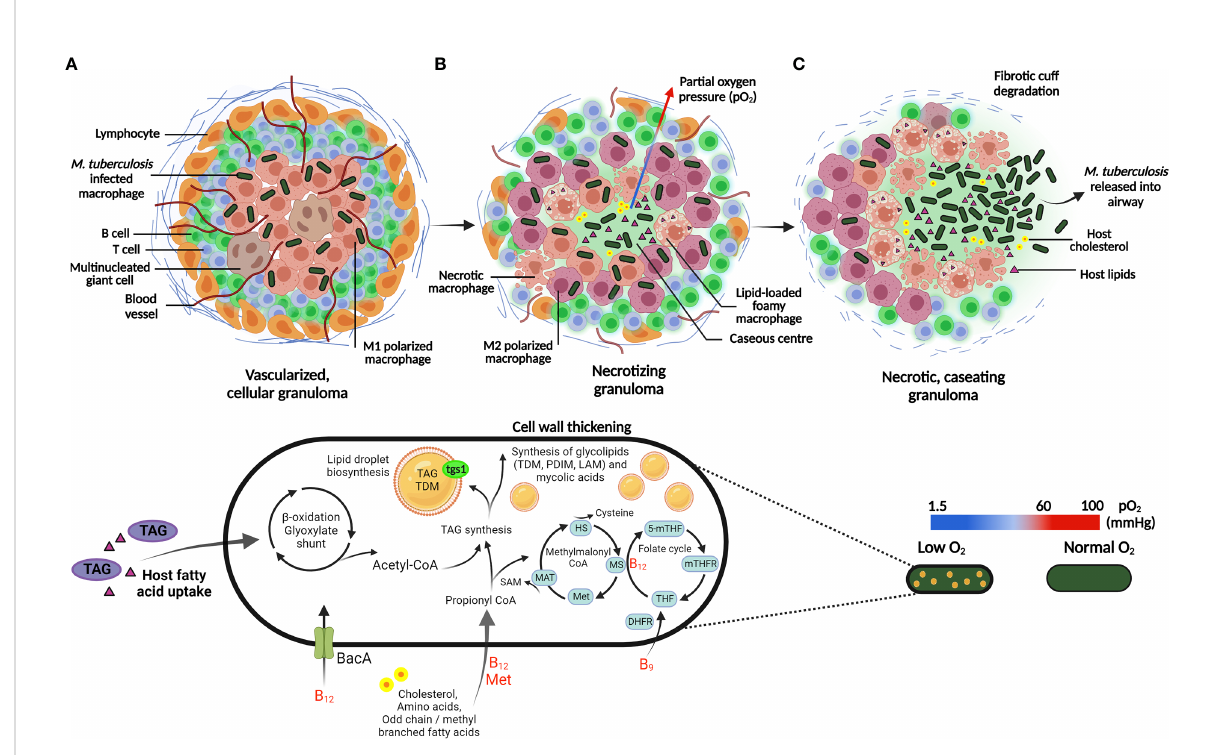
FIGURE 3 Adaptation of M. tuberculosis to the host granuloma environment and associated stressors. (A) M. tuberculosis is phagocytosed by alveolar macrophages and contained within the center of the granuloma, which is an organized aggregate of immune cells recruited to the site of in fl ammation. The pro-in fl ammatory cytokines, IFN-y and TNF- a activate macrophages (M1 polarized; pink macrophages), which is essential for the control of infection. Following host immune activation, recruitment of lymphocytes, largely comprising of T and B cells, surround the periphery of the granuloma. (B) Mature granulomas develop heterogeneous vasculature, displaying a gradient of pro-in fl ammatory host cells (M1 and M2 polarized; pink and purple macrophages, respectively) and a decreasing oxygen gradient toward the caseum. In response to hypoxia, M. tuberculosis exploit lipid-loaded foamy macrophages to store host TAG during persistence. Host fatty acids and cholesterol are metabolized by the b -oxidation and methylmalonyl CoA pathway respectively, which generates a nutritional carbon source that can be stored in lipid droplets or utilized to generate mycobacterial cell wall components. Essential vitamins utilized in the respective metabolic pathways (shown in red) are acquired by M. tuberculosis from the host environment via the ABC-transporter, BacA. (C) Necrotic macrophages contributes to an accumulation of lipid debris, resulting in central caseation in mature granulomas. Eventual rupture of the granuloma leads to extracellular dissemination of M. tuberculosis. HS: homocysteine; MS: methionine synthase; Met: methionine; MAT: methionine adenosyltransferase; 5-mTHF: 5-methyltetrahydrofolate; mTHFR: methylenetetrahydrofolate reductase; THF: tetrahydrofolate; DHFR: dihydrofolate reductase. Created with